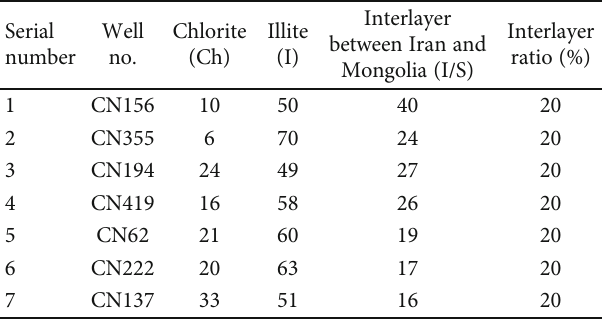
Table 3: Relative content analysis of clay minerals of rock samples in the Longmaxi and Wufeng